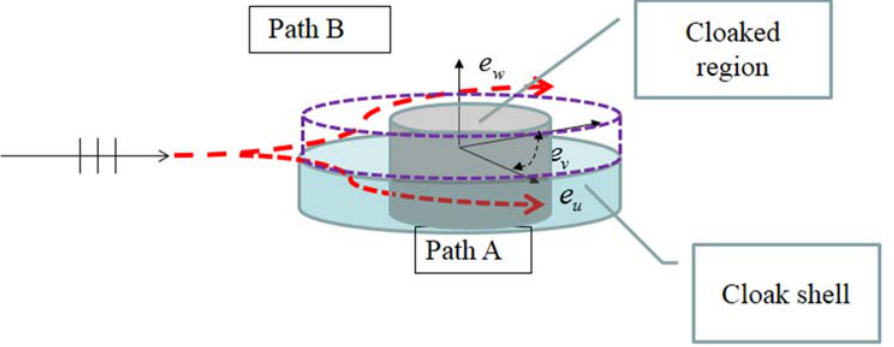
Figure 5. Pre ‐ determined path for wave propagation around the cloak shell. The anisotropic material properties of the cloak shell cause the direction of wave propagation to change from its original direction to a pre ‐ determined path.